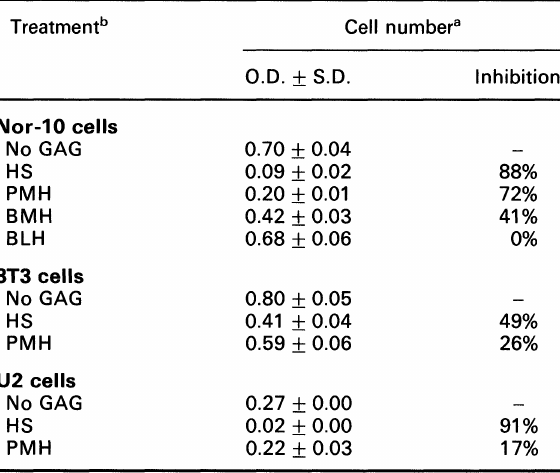
Table 1. Effect of GAGs on the proliferation of Nor-10 SMC, NIH 3T3 fibroblasts and U2 osteosarcoma cells